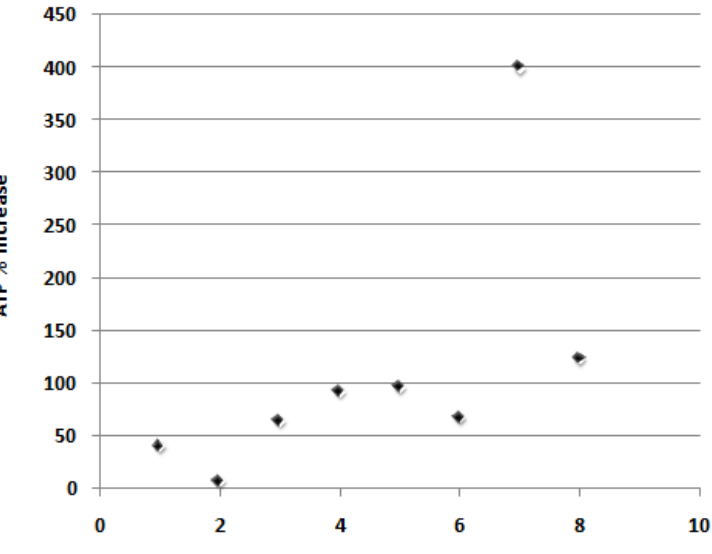
Figure 5. The distribution of ATP% increase for Chinese